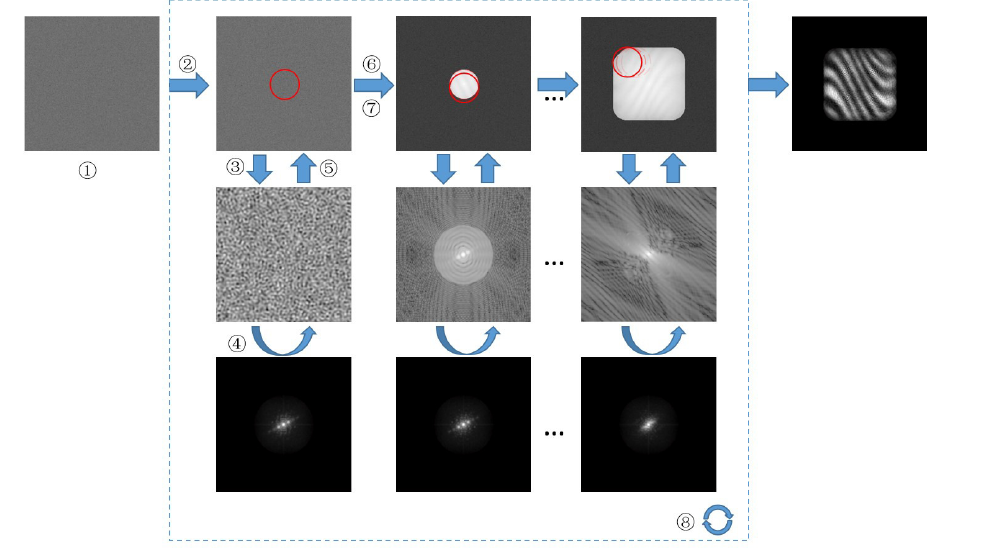
Figure 1. Diagram of the ptychographic iterative engine (PIE)